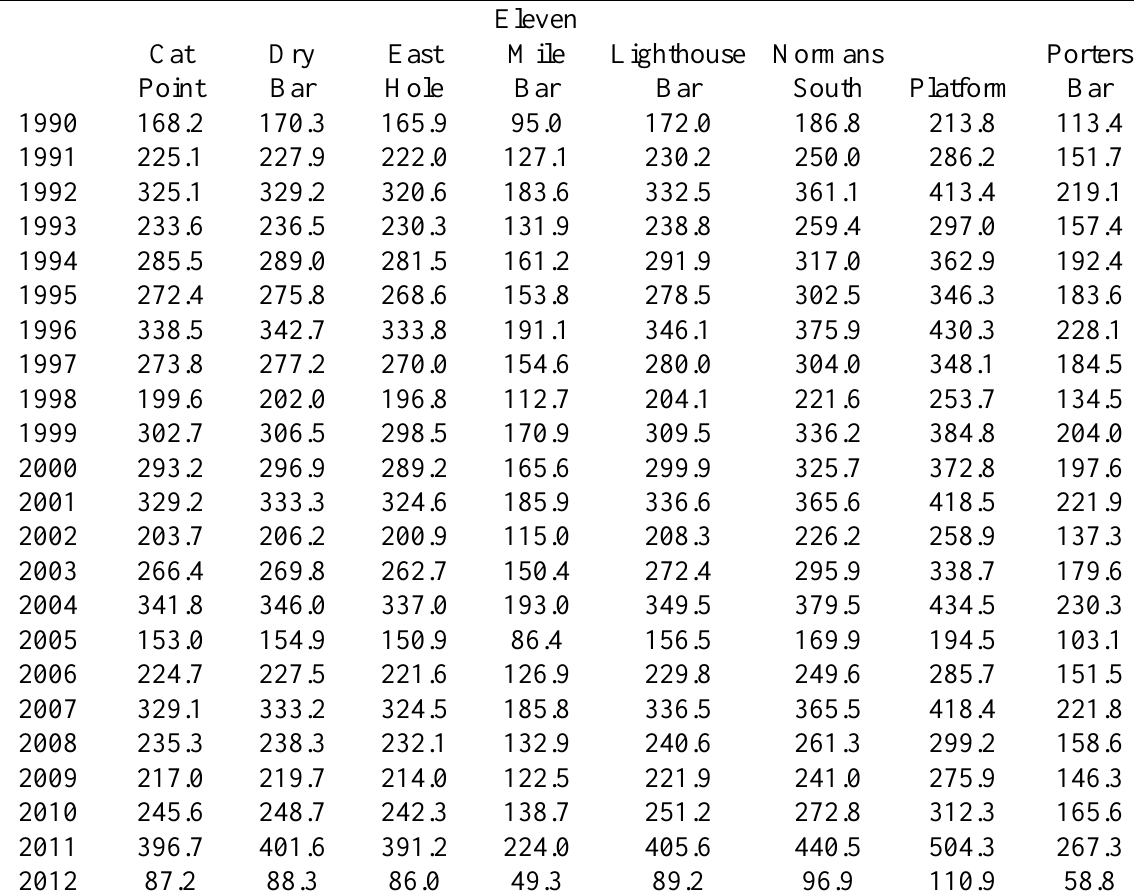
with bar and year